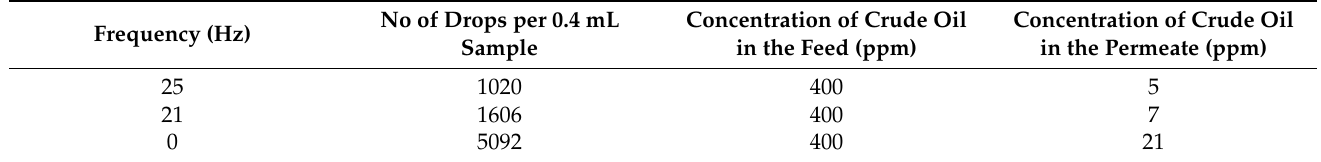
Table 1. Number of crude oil drops (30 ◦ American Petroleum Institute) and concentration of oil in the feed and permeate obtained at various frequencies of oscillation and a 400 l m − 2 h − 1 flux